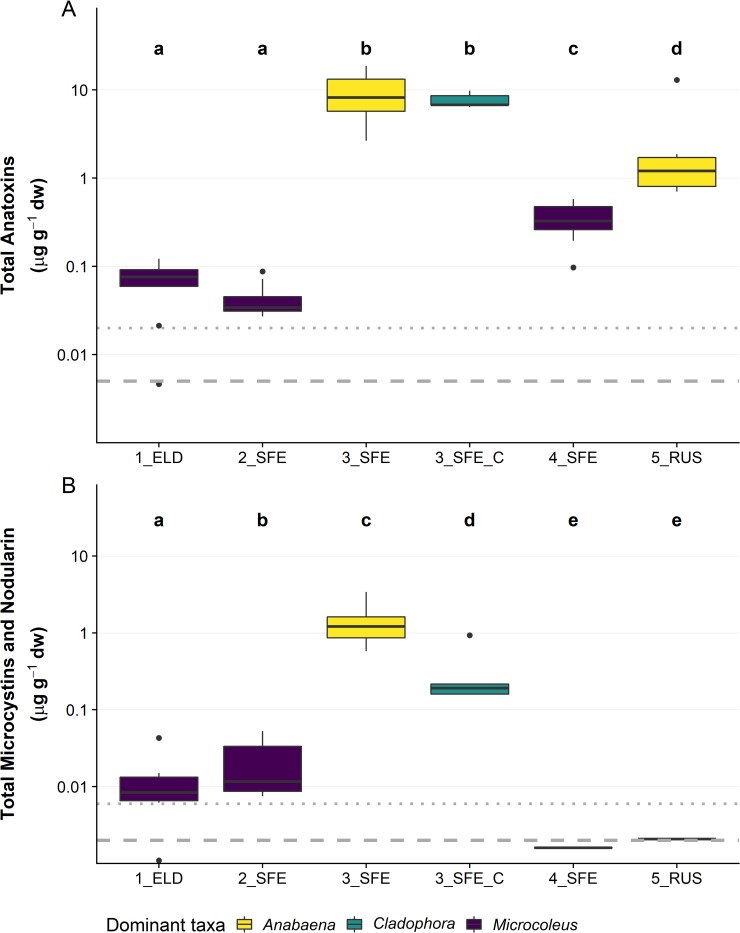
Anatoxin and microcystin/nodularin concentrations vary by site.(A) Summed anatoxin (the total of the four congeners; anatoxin-a, homoanatoxin-a, dihydroanatoxin-a and dihydrohomoanatoxin-a); and (B) summed microcystins and nodularin-R from 10 replicate attached periphyton samples (n = 5 for Cladophora-dominated samples; 3_SFE_C). collected from each of four sites on the Eel River on 29 July 2018 and 9 attached periphyton samples from one site on the Russian River on 31 July 2018. Colours represent the dominant taxa in mats collected from each site. dw = dry weight. Note log scale on the y-axes. Lines within the boxes are medians, the ends of boxes are quartiles and whiskers extend to the lowest or highest data point ≤ 1.5 × the interquartile range. Black dots are outliers. A Kruskal-Wallis test and pairwise Wilcoxon rank sum test with a Benjamini-Hochberg adjustment was used to identify sites that were significantly different from one another (p <0.05), denoted by the letter above the plot. Dotted lines represent the analytical limit of quantitation and bold dashed lines the analytical limit of detection.